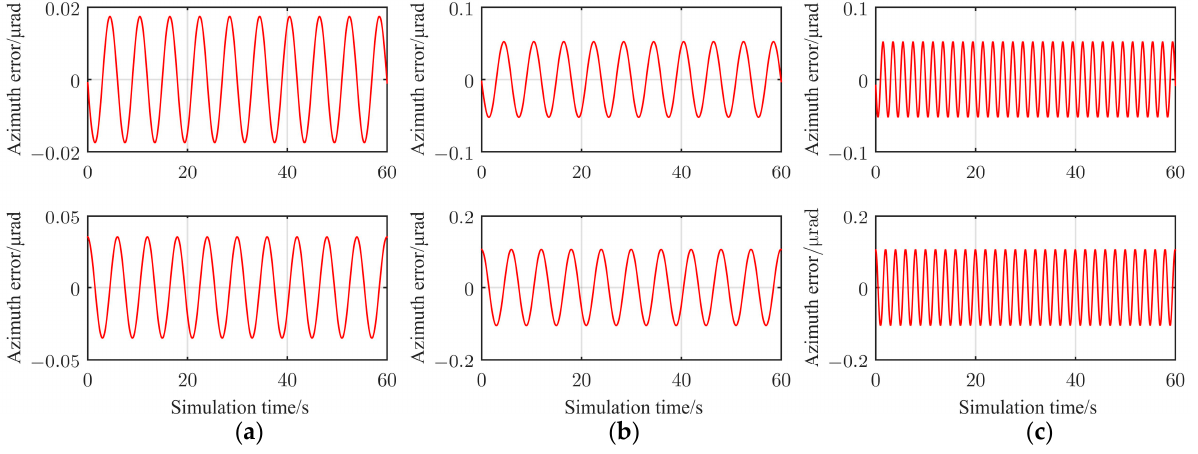
Figure 7. The LOS a tt itude curves under the condition of conical motion in an ideal state in the Figure 7. The LOS attitude curves under the condition of conical motion in an ideal state in the re fl ector coordinate system O 41 X 41 Y 41 Z 41 . ( a ) a = 1°, ω = 60°/s; ( b ) a = 3°, ω = 60°/s; ( c ) a = 1°, ω = 180°/s. reflector coordinate system O 41 X 41 Y 41 Z 41 . ( a ) a = 1 ◦ , ω = 60 ◦ /s; ( b ) a = 3 ◦ , ω = 60 ◦ /s; ( c ) a = 1 ◦ , ω = 180 ◦